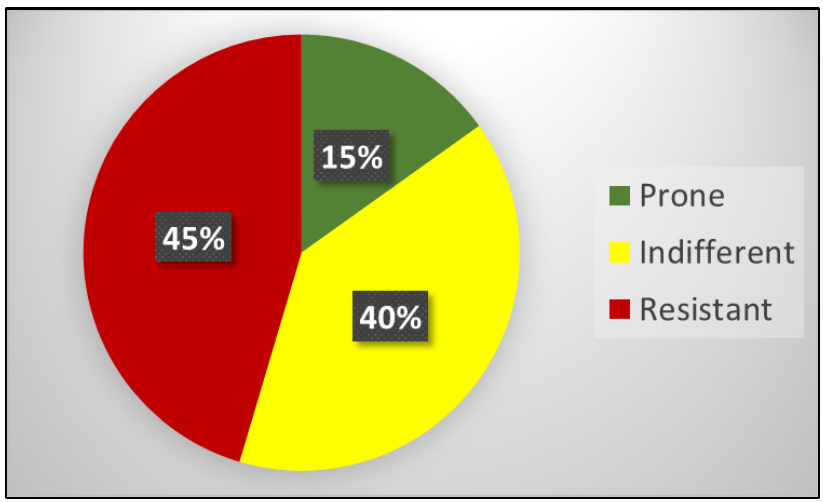
Figure 13. Hotel Guests’ Energy -Use Profiles.